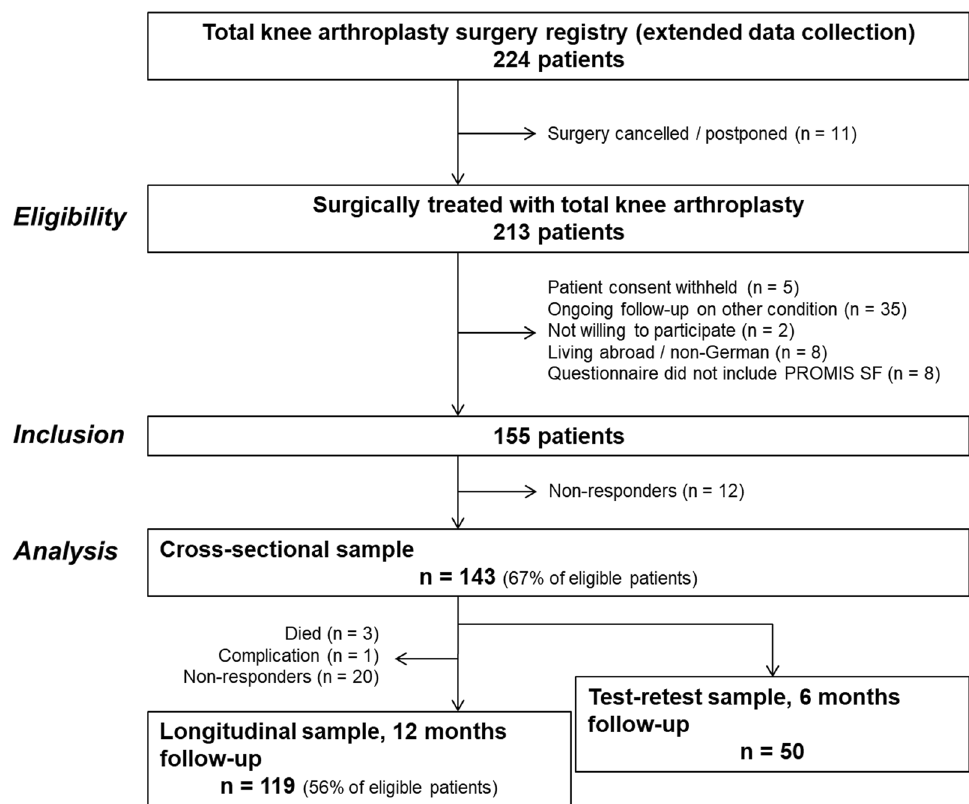
Fig. 1 Flow chart showing patient eligibility and sample sizes for assessing German PROMIS short form measurement